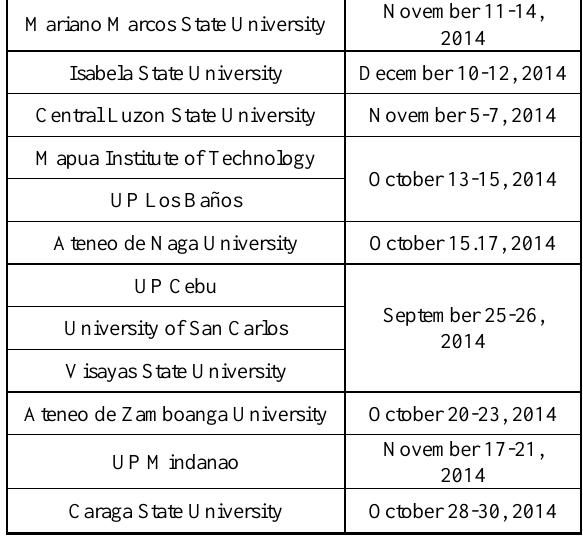
Table 1. Schedule of trainings conducted during the project's 1st year of implementation